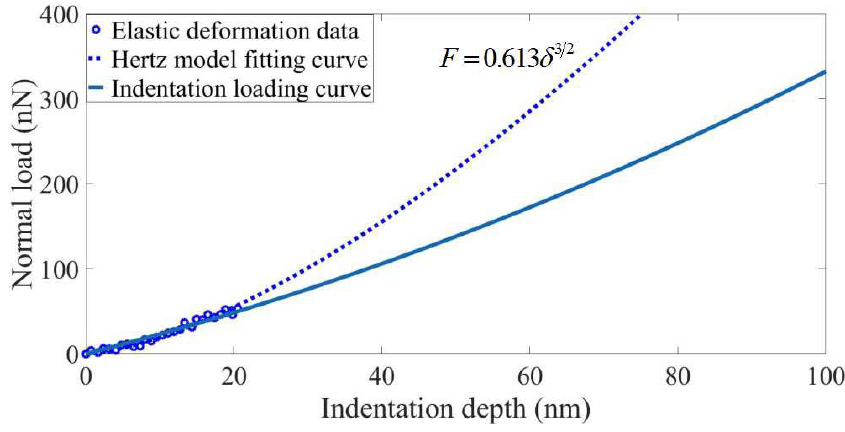
Figure 5. Hertz model fitting of indentation data for wear Probe 2 .